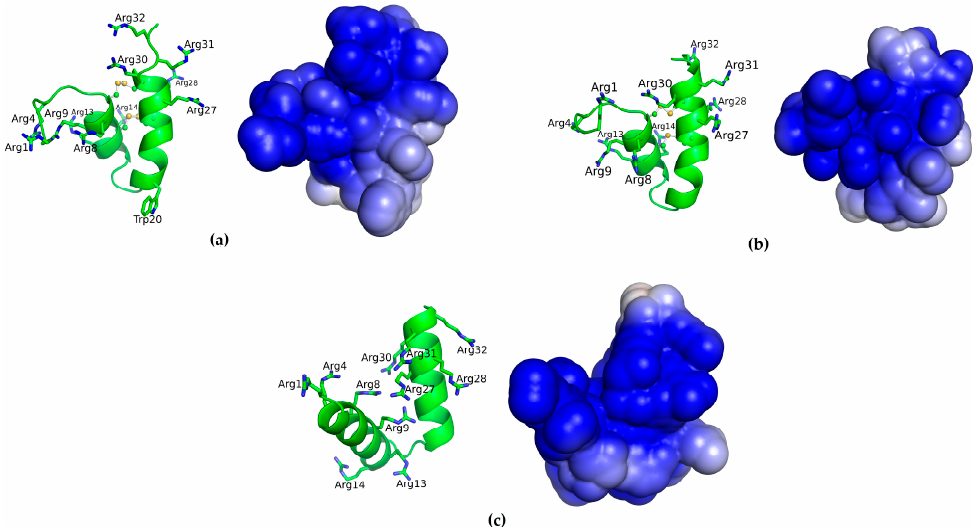
Figure 2. Three-dimensional models of MBP-1 and their variants. Right images represent the electrostatic surface of peptides, where blue represents positive areas and white represents uncharged areas. The models of MBP-1 ( a ); Var 1 ( b ) and Var 2 ( c ) show, respectively, a DOPE score of − 1943.4, − 1862.9 and − 2328.6; a Z -Score of − 4.43, − 5.01 and − 3.21; and 96.8%, 96.8% and 100% or residues in favored regions of Ramachandran Plot. Table 2. Solvation potential of MBP-1 and variants 1 and 2.